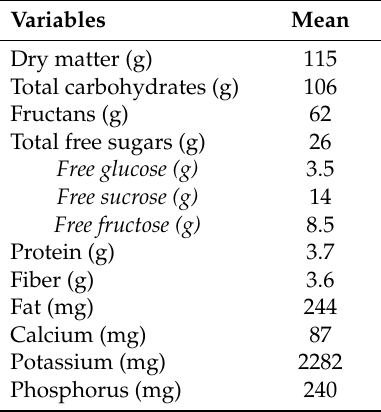
Table 1. Chemical composition of 1 kg fresh yacon root